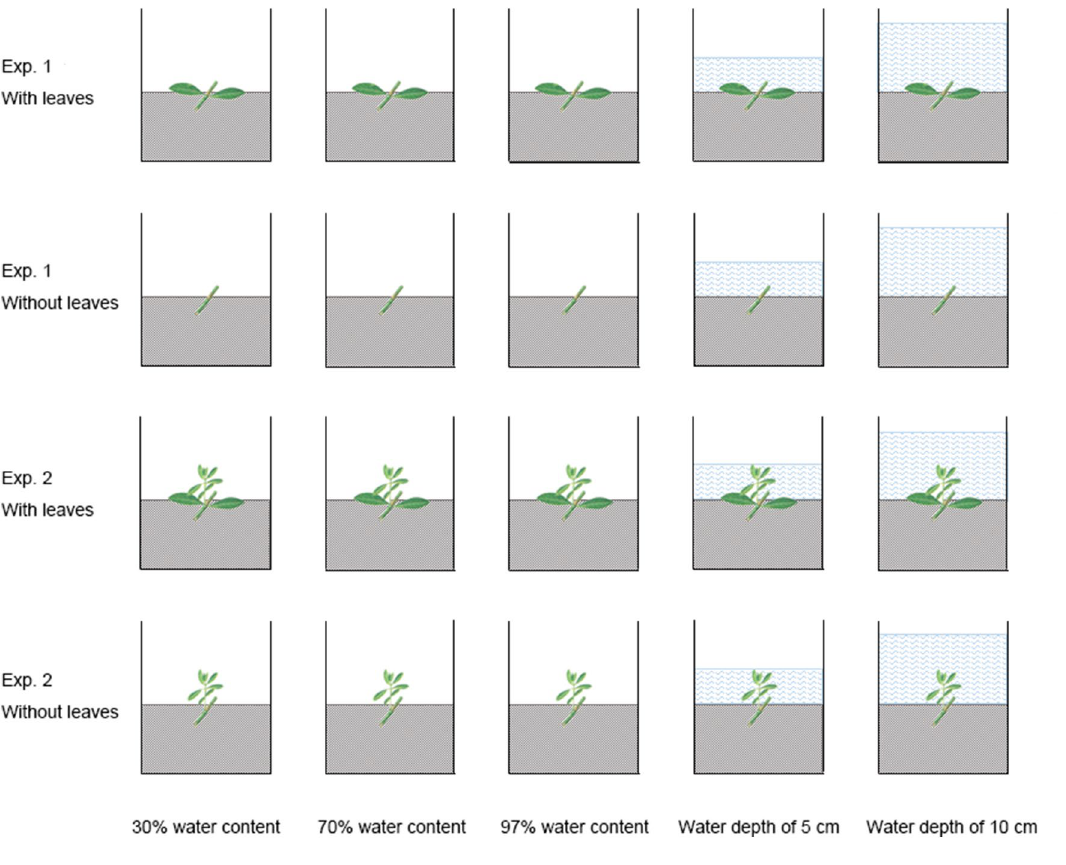
Figure 3. Schematic representation of the experimental